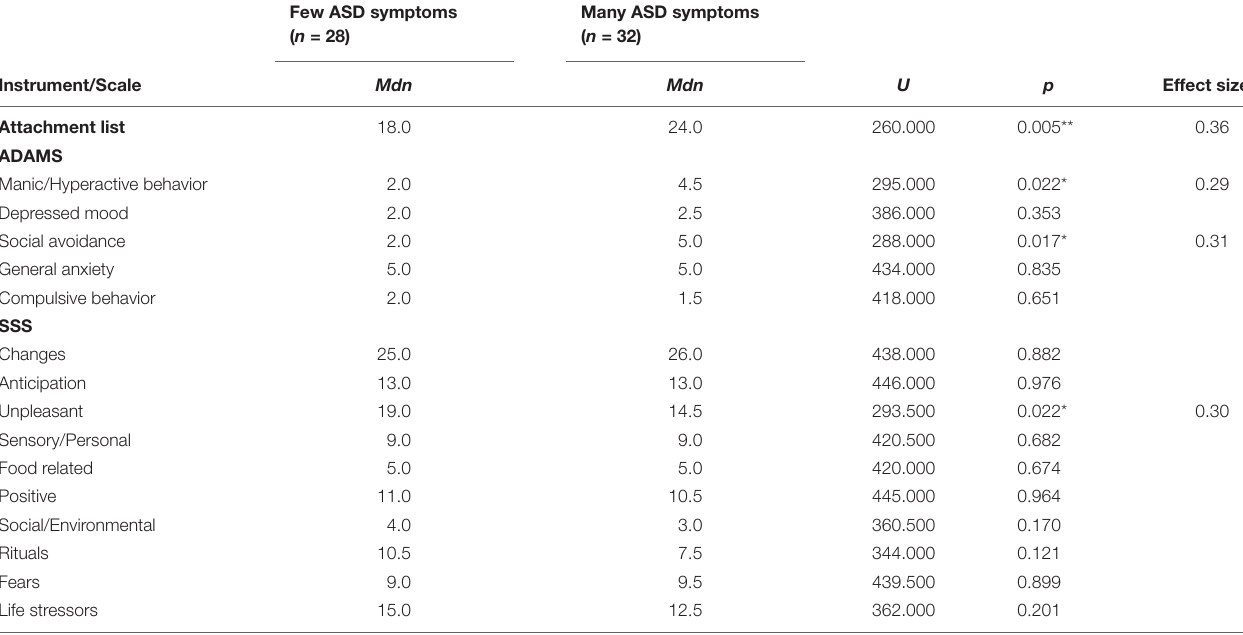
TABLE 4 | Differences between groups with few and many symptoms of ASD on attachment, anxiety, depression and mood, and stress. Few ASD symptoms Many ASD symptoms ( n = 28) ( n =